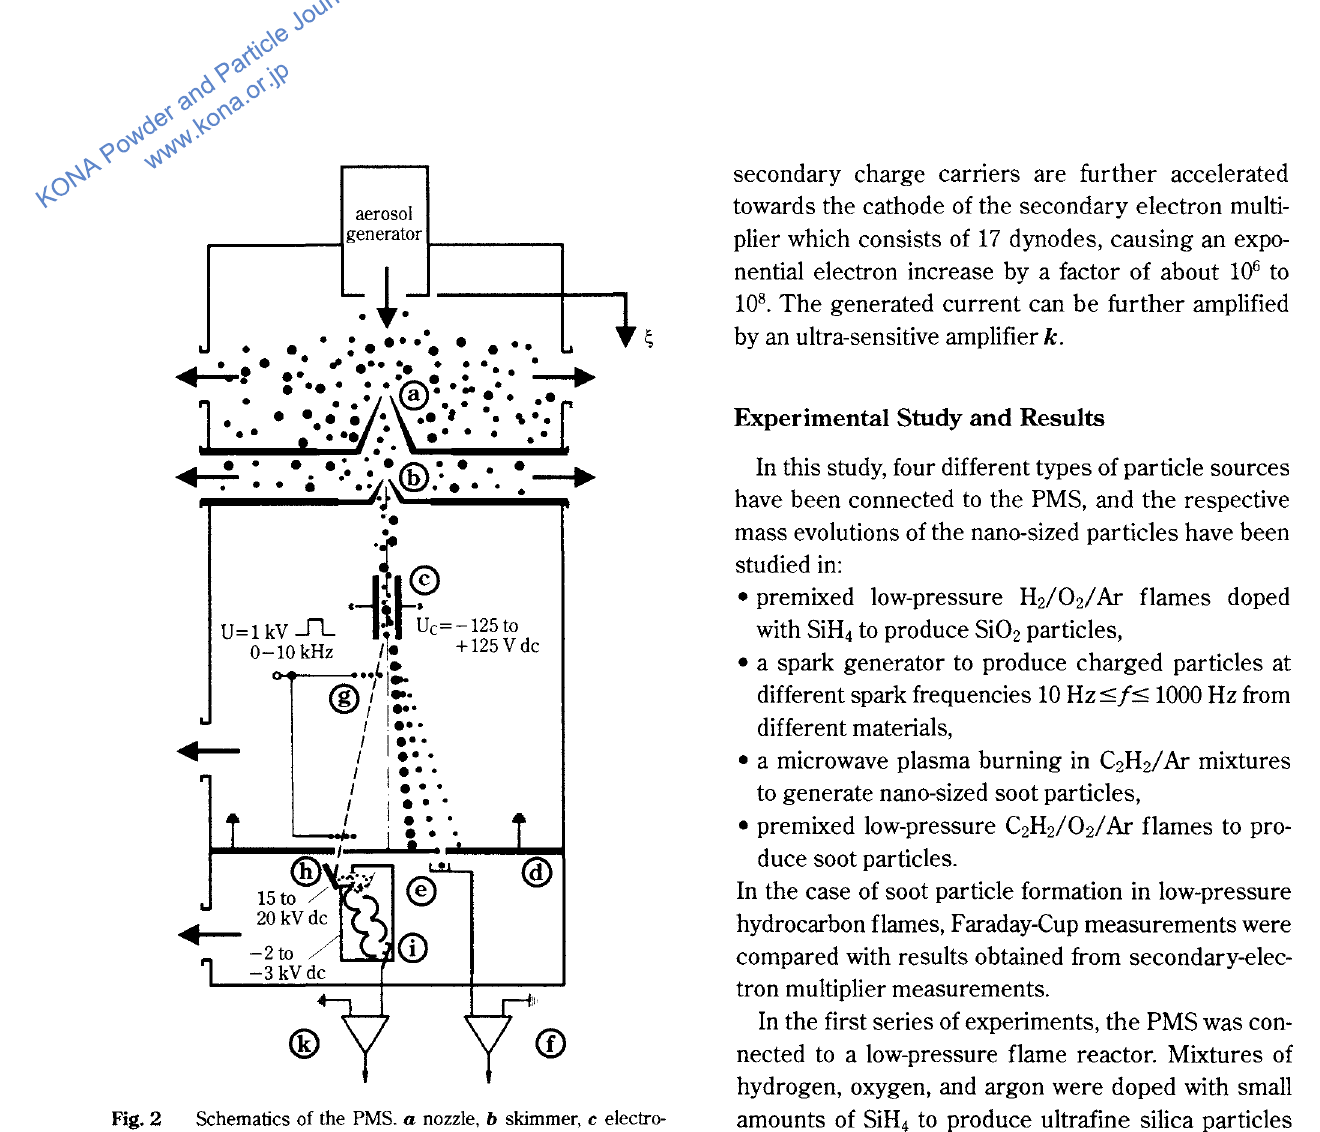
Fig. 2 Schematics of the PMS. a nozzle, b skimmer, c electro static deflection plates, d electrically grounded blend with slits, e Faraday-Cup, f electrometric amplifier, g repelling grids, h conversion dynode, i secondary electron ampli fier, k electrometric